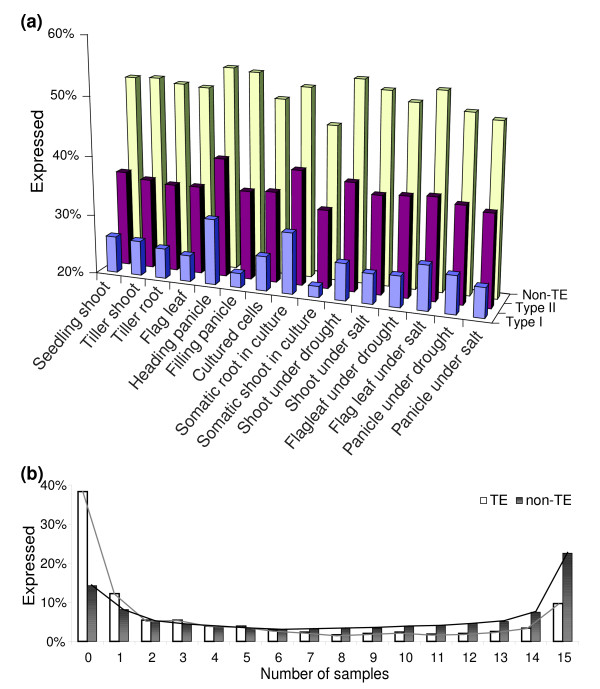
Summary of expression of TE-related genes. (a) Percentage of the transcribed type I and type II TE-related genes and non-TE-related genes in different samples. Percentages of transcribed genes in each category are shown for all samples. (b) Levels of transcription can be inferred based on how often (in how many different samples) expression was detected for TE-related and non-TE-related genes. TE, transposable element.